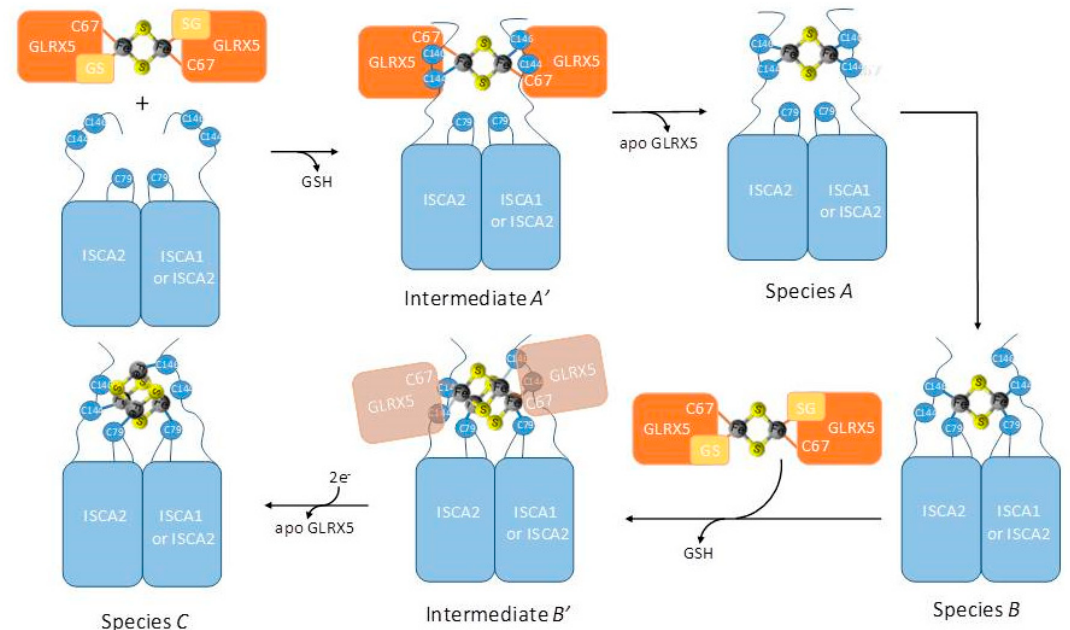
Figure 2. Model of the [4Fe–4S] cluster assembly mechanism by holo-GLRX5, apo-ISCA1/ISCA2 interactions. Adapted from Reference [78].